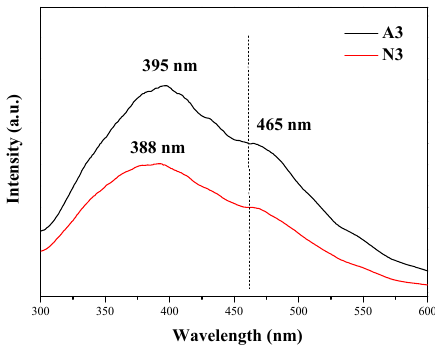
Figure 8. Photoluminescence spectra of A3 and N3